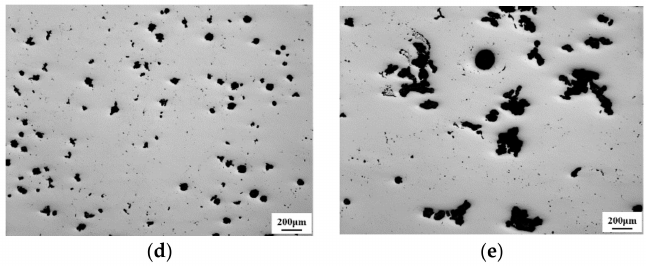
Figure 6. Graphite morphology in the bonding interface. ( a – e ) → high speed steel (HSS) side to DCI side.